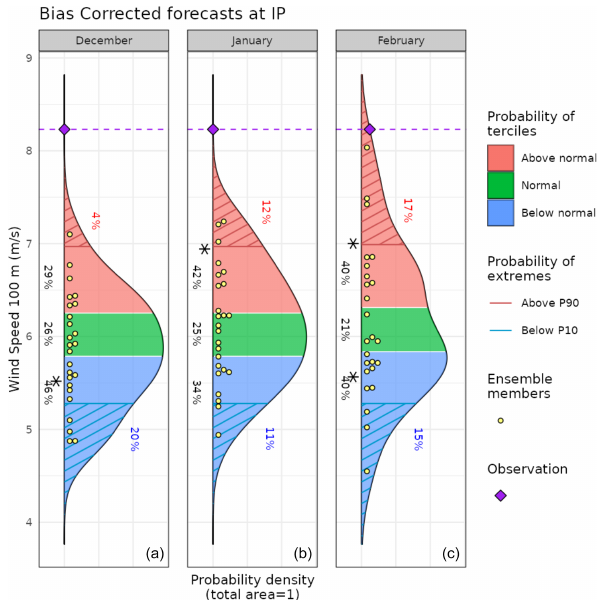
Figure 8. Seasonal forecasts of wind speed at 100m height, aver- aged over 10 ◦ W–4 ◦ E and 36–44 ◦ N for March 2018. Each panel corresponds to forecasts launched 3 to 1 month(s) ahead (from pan- els a to c ). The methodology is a simple bias correction with ERA5 observations, based on previous hindcasts since 1993. An asterisk indicates the tercile with the highest probabilities.